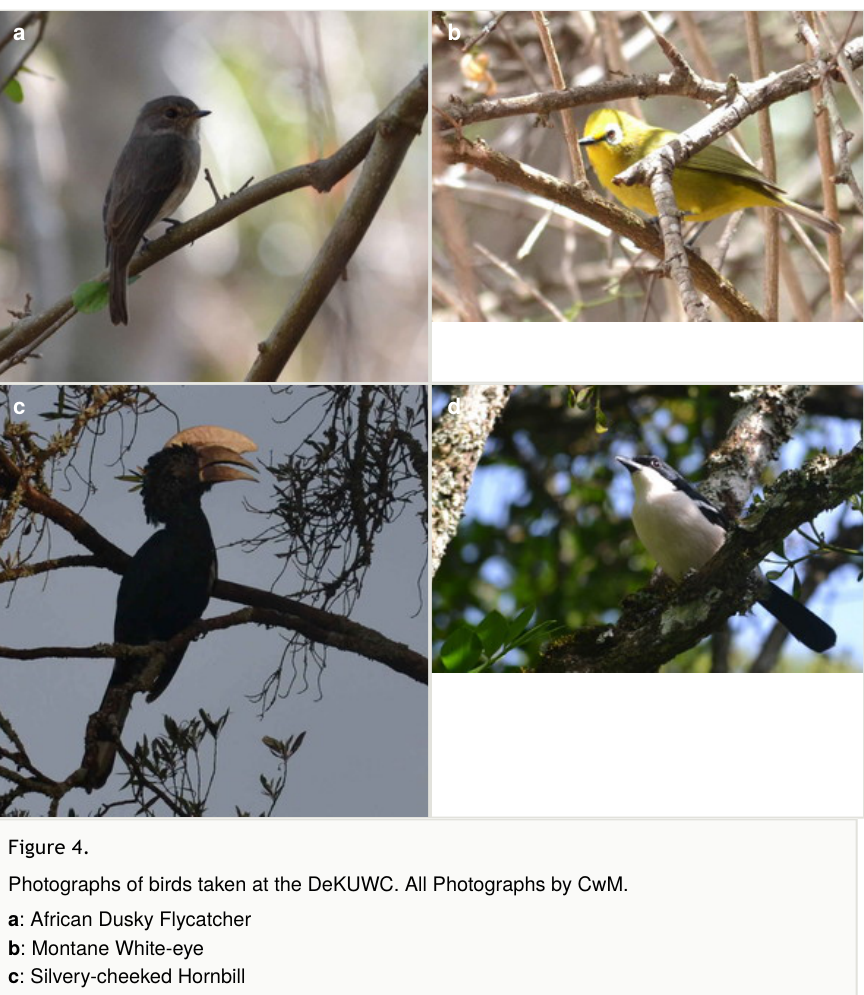
Photographs of birds taken at the DeKUWC. All Photographs by